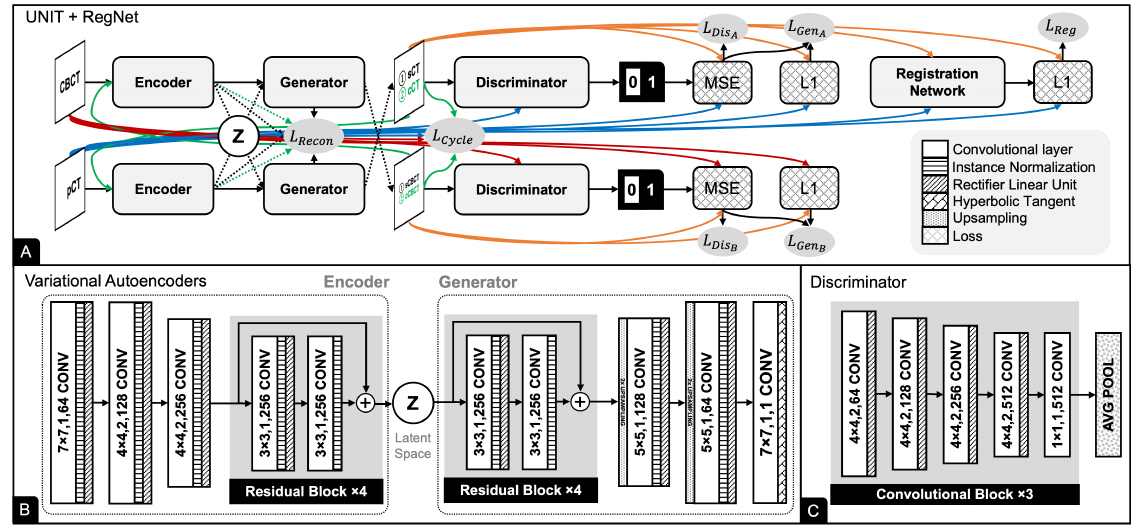
Figure 5. UNIT combined VAEs and GANs for CBCT to CT translation. ( A ) UNIT comprises six subnetworks: two encoders, two generators, and two discriminators. ( B ) The encoder consists of three convolution blocks and four residual blocks to map an image in the source domain into the shared latent code, while the discriminator consists of four residual blocks and three convolution blocks to decode the latent code into an image in the target domain. ( C ) The discriminator con- sists of a series of convolutions, nonlinear activations, and average pooling operations. Values in the convolutional layer box indicate the size of kernel, the number of strides, and the number of channels,